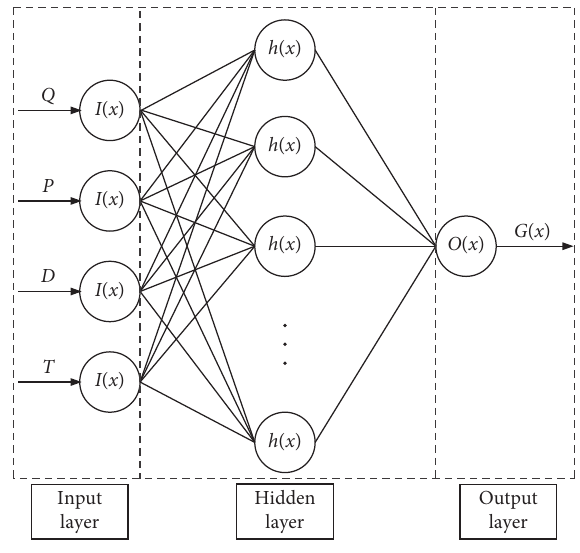
Figure 4: Backpropagation Table 5: Comparison of ANN and NLR model results with experimental measurements and their relative error.